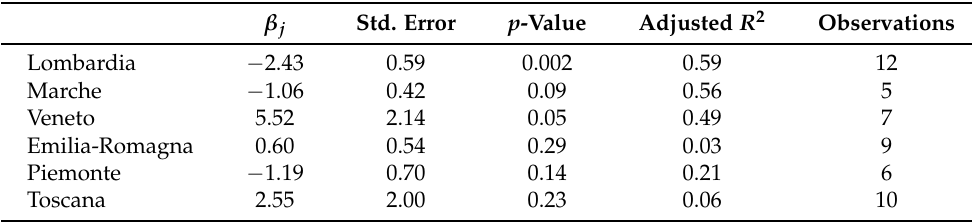
Table 2. Region-specific